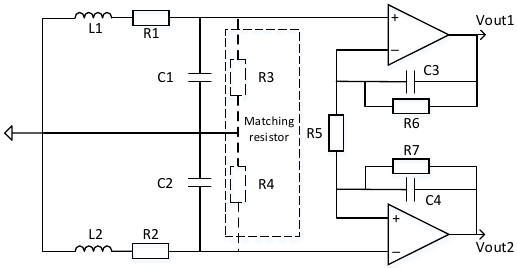
Figure 5. Sensor and op amp equivalent circuit diagram.